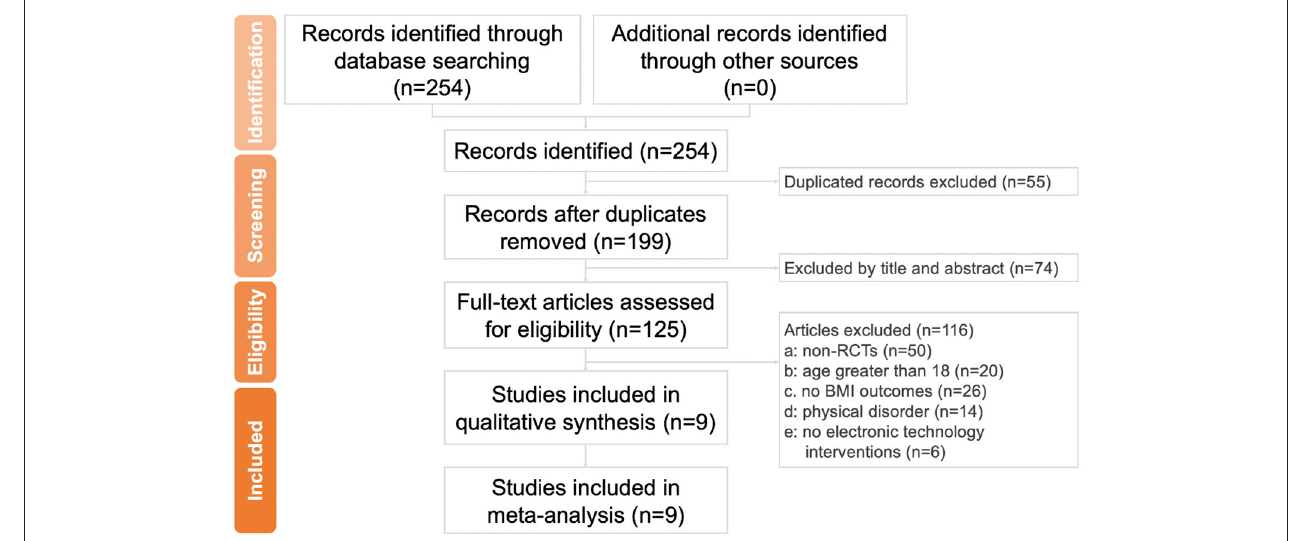
FIGURE 1 | Flow diagram of the study selection